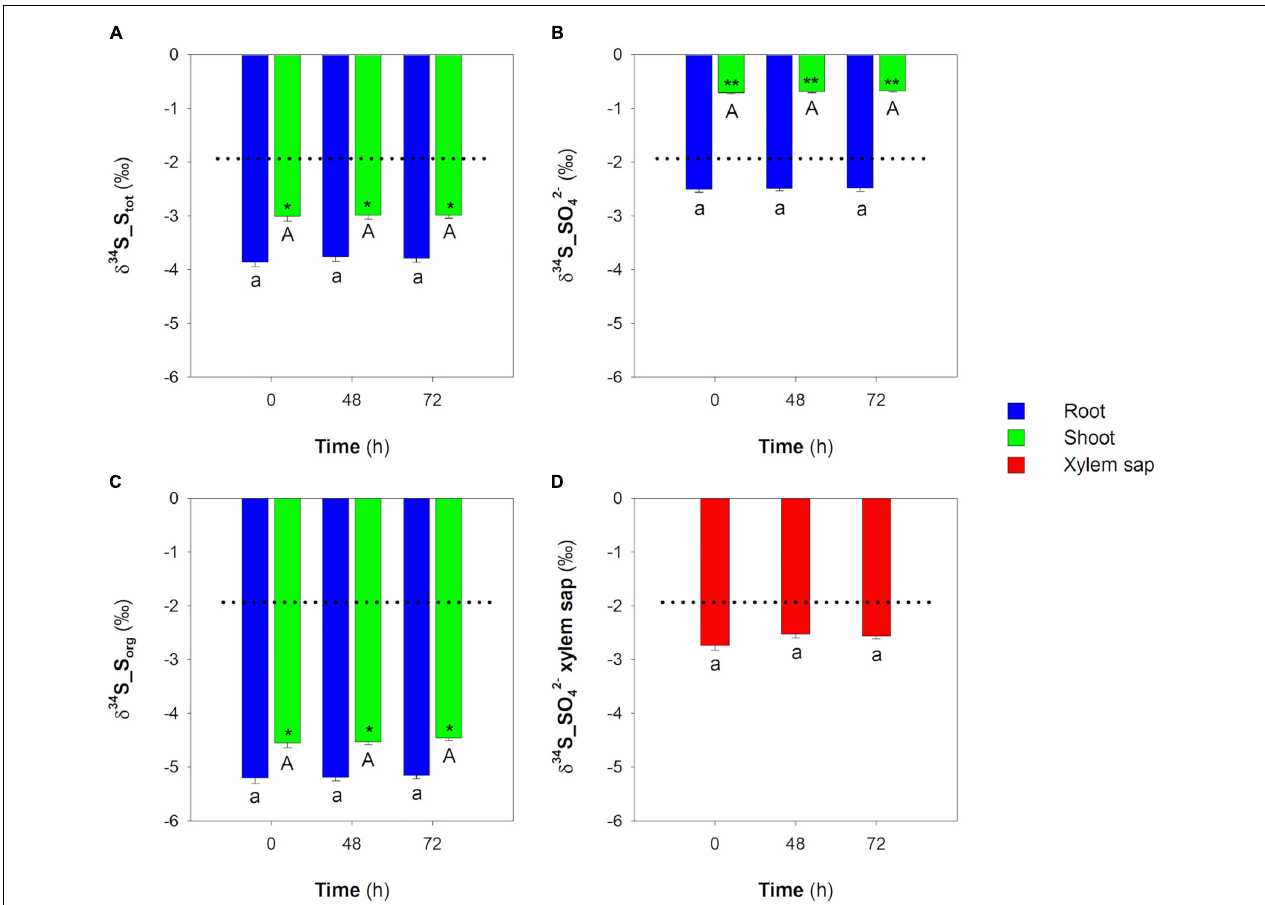
FIGURE 5 | Sulfur isotope composition of the main S pools in root and shoot and of SO 42 − in the xylem sap of rice plants grown in the presence of SO 42 − in the hydroponic solution. (A) S isotope composition of S tot in root and shoot. (B) S isotope composition of SO 42 − in root and shoot. (C) S isotope composition of S org in root and shoot. (D) S isotope composition of SO 42 − in xylem sap. Dotted lines indicate the δ 34 S value of the S source used in the experiment ( δ 34 S_SO 42 − source = − 1.92 ± 0.02 ). Data are means ± SE of three independent experiments run in duplicate ( n = 3). Asterisks indicate significant differences (Student’s t -test; *0.001 ≤ P < 0.05; ** P < 0.001) between root and shoot of plants sampled at the same time. Different letters indicate significant differences (cid:104) between the samples (root, shoot, or xylem sap) at different times ( P <